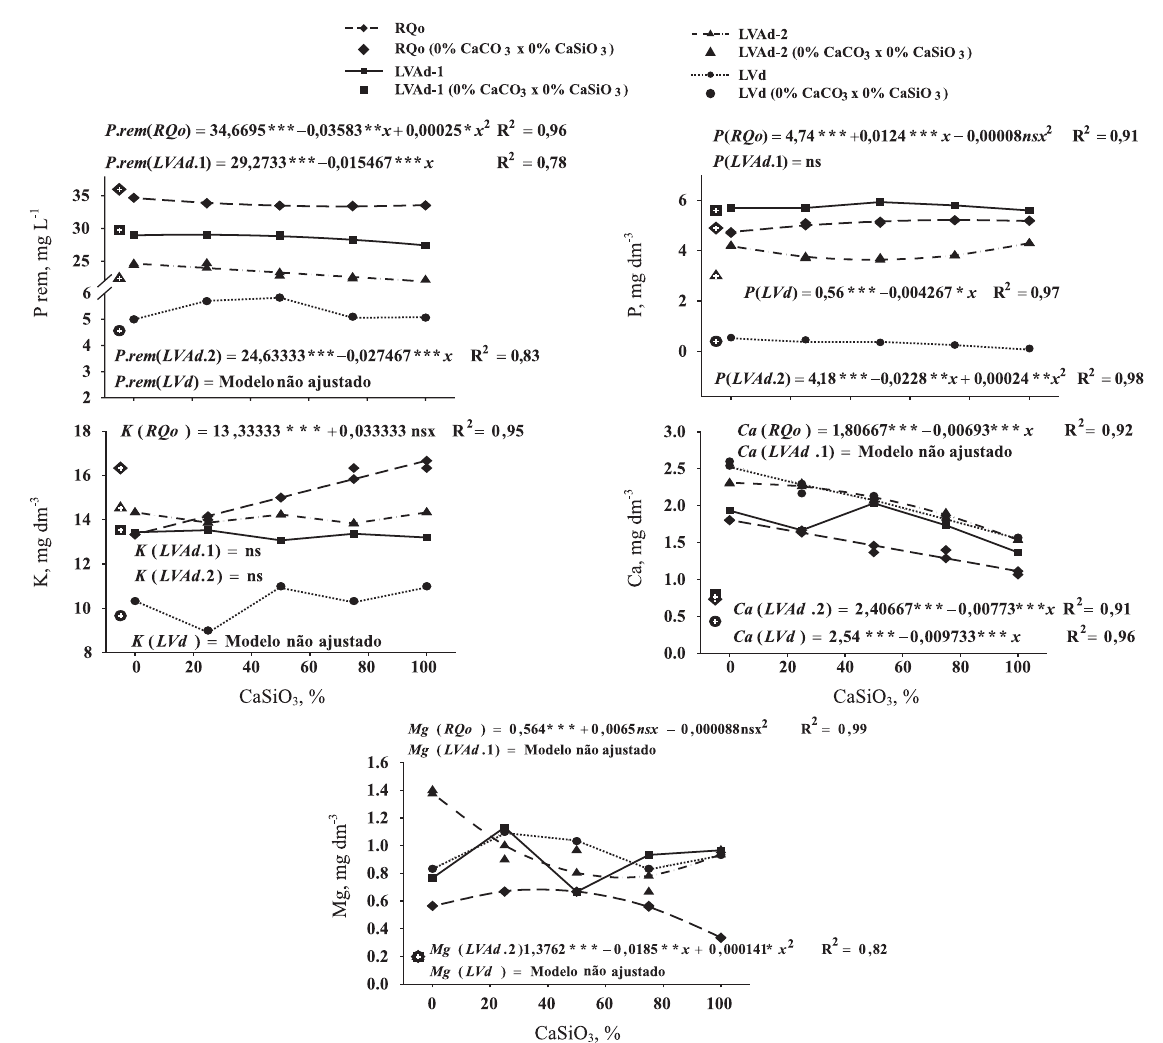
Figura 1. Influência da substituição do CaCO nos solos RQo, LVAd-1, LVAd-2 e LVd e solos sem correção. ***, **, * e ns: significativo a 0,1; 1 e 5 %, e não- significativo,